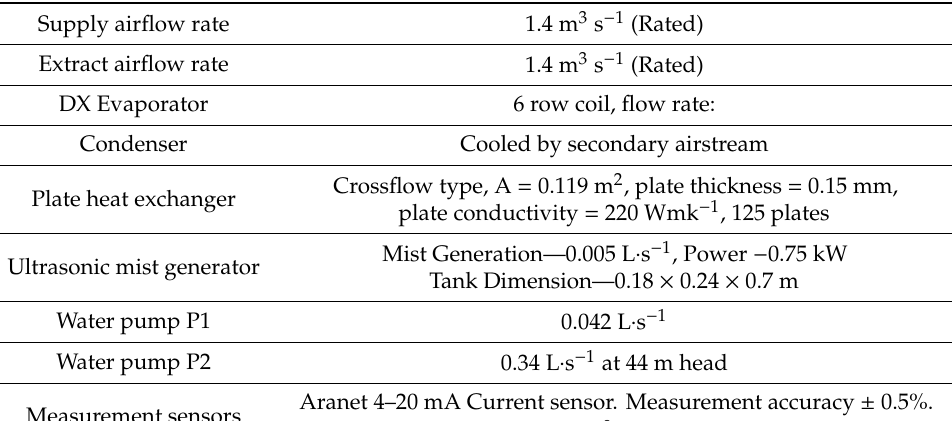
Table 1. Key parameters of fresh-air-handling unit (FAHU) test